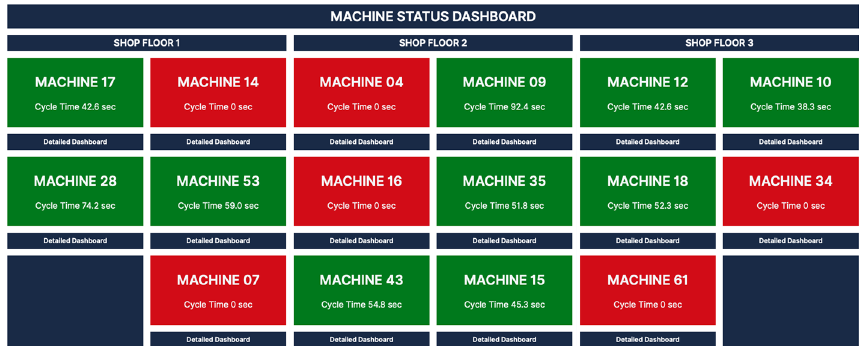
the box is green. If it is not working, then the color is red. The average cycle time for each machine is shown on the dashboard. Users can reach the detailed dashboards over the links on this